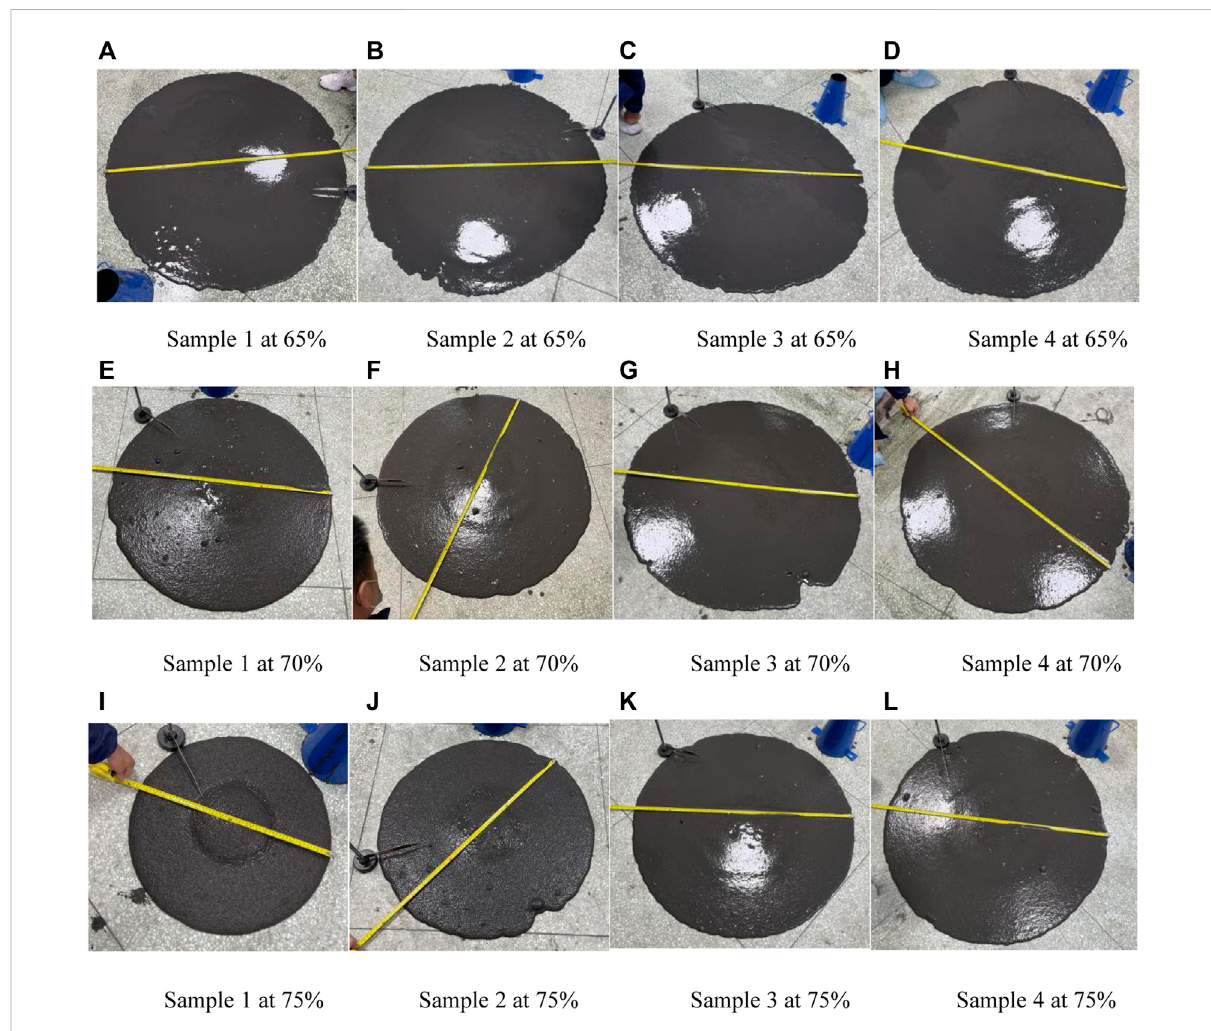
FIGURE 5 Slumptestof gangueslurry with differentconcentrations. (A) Sample1at65%, (B) sample2 at65%, (C) sample 3at65%, (D) sample4 at65%, (E) sample 1 at 70%, (F) sample 2 at 70%, (G) sample 3 at 70%, (H) sample 4 at 70%, (I) sample 1 at 75%, (J) sample 2 at 75%, (K) sample 3 at 75%, and (L) sample 4 at